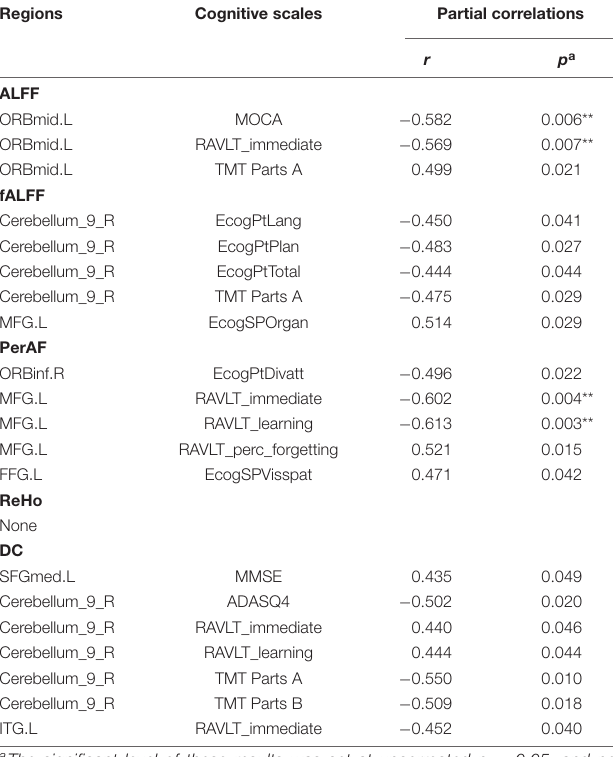
TABLE 3 | Significant partial correlations between cognitive scale scores and brain region metrics with significant group differences.